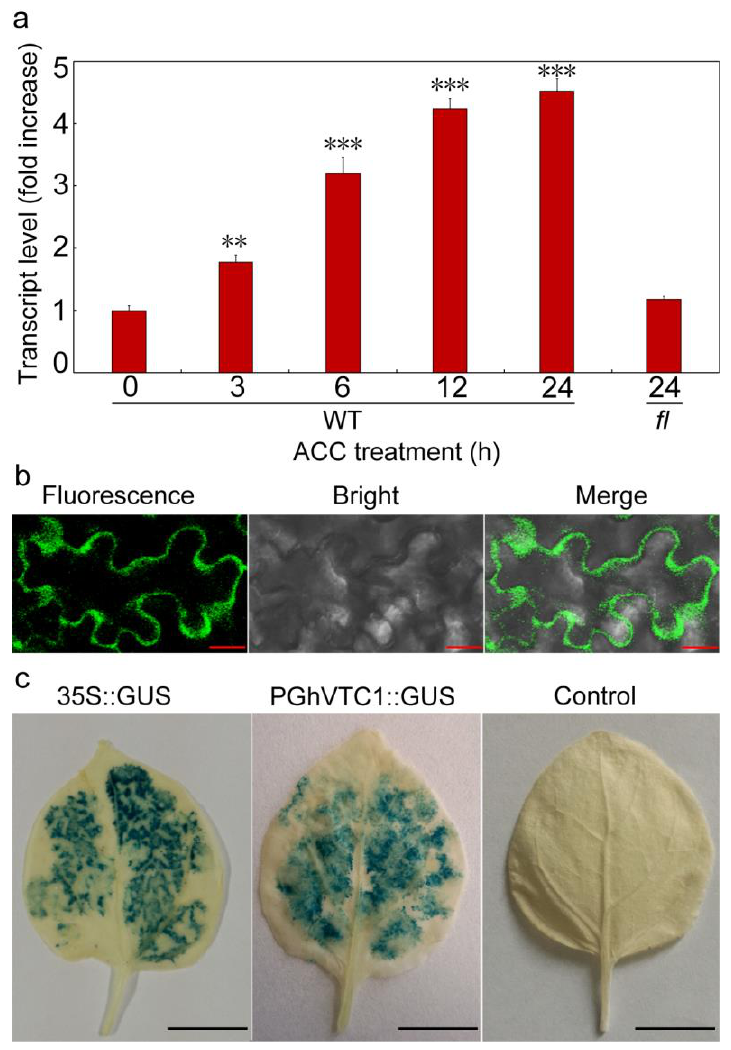
Figure 6. Analyses of transcript expression of GhVTC1 under aminocyclopropane-1-carboxylic acid (ACC) treatment and promoter activity of PGhVTC1 . ( a ) Expression analysis of GhVTC1 under ACC treatment at the transcriptional level. The WT and fuzzless-lintless ( fl ) mutant ovules were cultured for 7 days in vitro, and then were treated by ACC as presented time points. The treated cotton materials were used for RNA extraction and successive qRT-PCR analysis. ( b ) Fluorescence detection of green fluorescent protein (GFP) expression in PGhVTC1 transgenic tobacco leaves. The PGhVTC1::GFP-GUS transgenic tobacco leaves were used to detect the GFP expression (bright field, fluorescence, and merged images) by fluorescence microscopy. ( c ) GUS histochemical staining of transgenic PGhVTC1::GFP-GUS tobacco leaves. Bars = 50 µ m (in b ) and 1 CM (in c ). ** and *** indicate p < 0.01 and 0.001 compared to 0-h